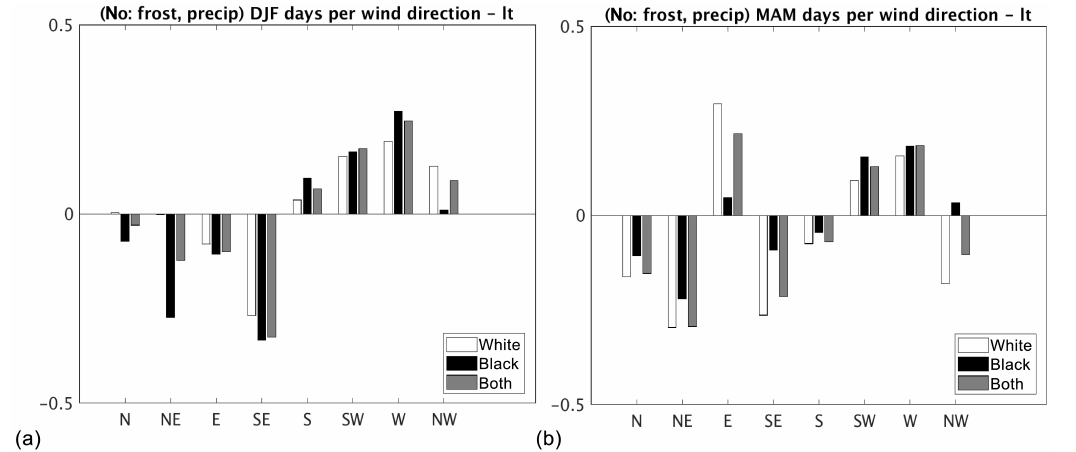
Figure 3. Correlation coefficients between the number of days per wind direction without frost and precipitation days, and the dune thickness (lt-layer thickness) of the white layer (white), black layer (black), and both together (grey). The correlations are shown for the seasons winter (DJF) and spring (MAM) and for the eight wind directions.